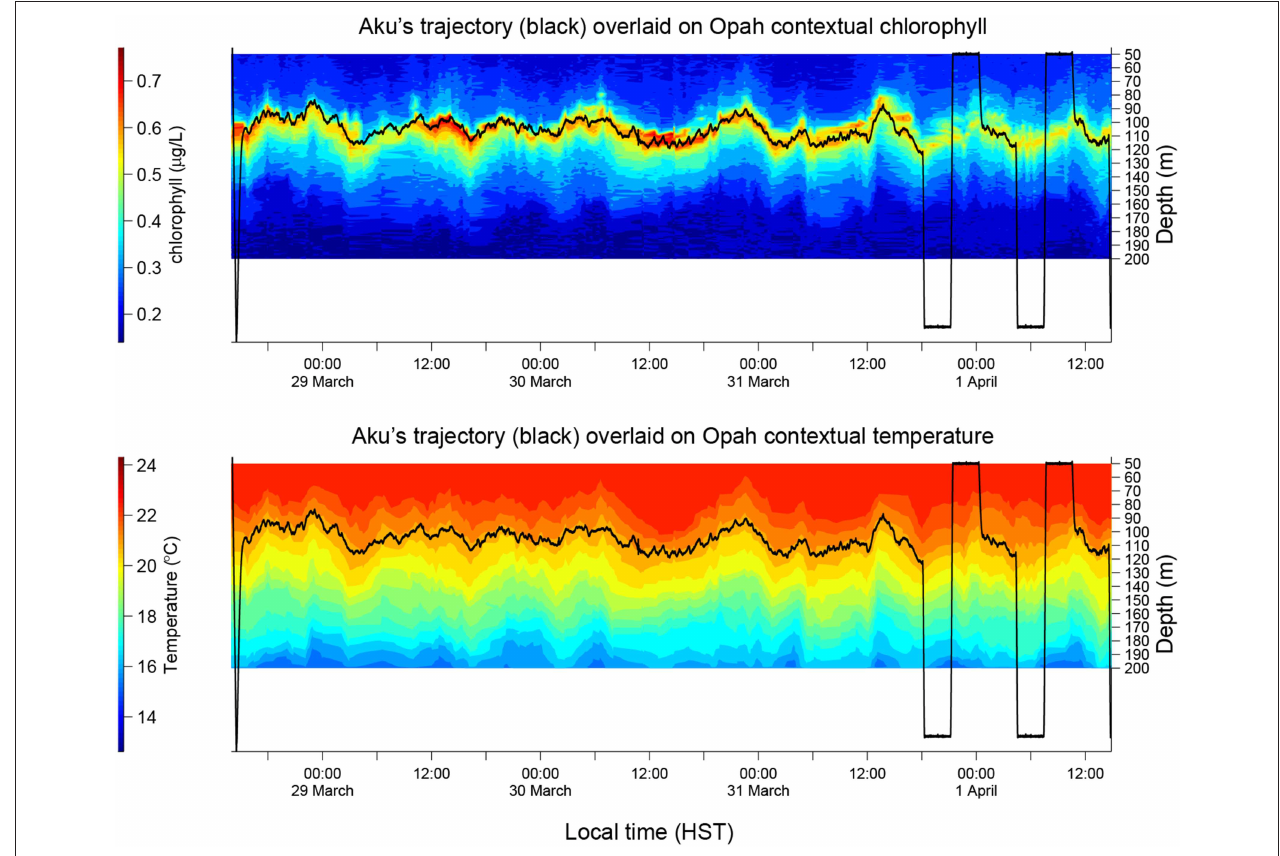
FIGURE 10 | Aku ’s depth trajectory overlaid on Opah -measured contextual chlorophyll (Upper) and temperature (Lower) , respectively, during Aku ’s 4-day sampling mission in the 2018 Hawaiian Eddy